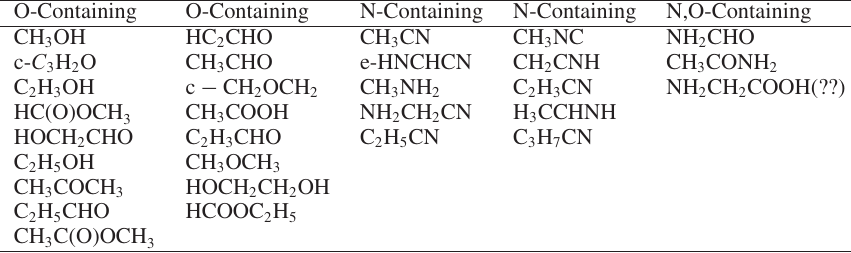
Table 2. Complex Organic Molecules Associated with Hot Cores and Corinos.